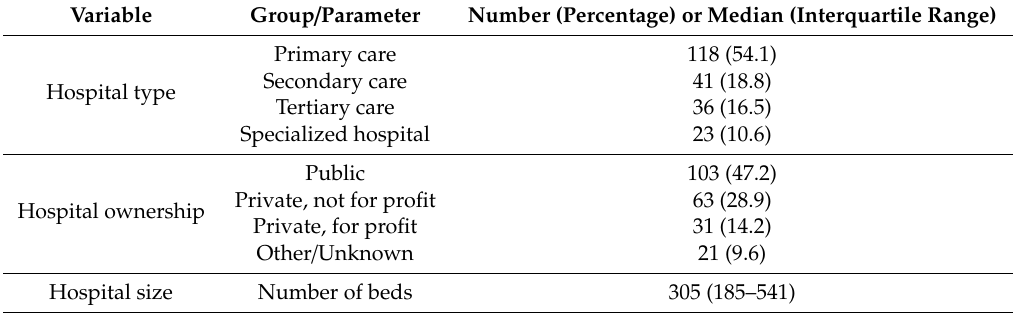
Table 1. Baseline characteristics of the 218 hospitals that participated in the point prevalence survey 2016.